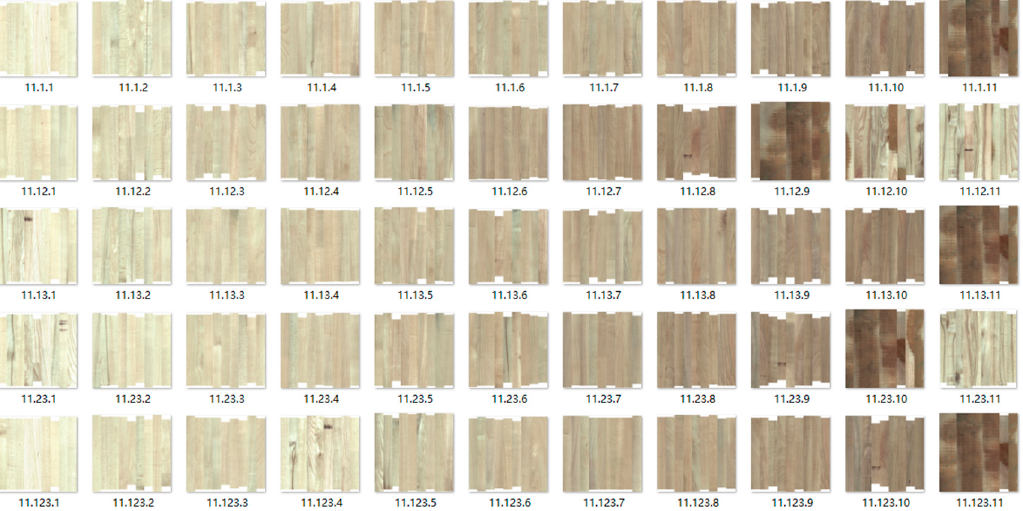
Figure 10. K = 11 clustering result images.